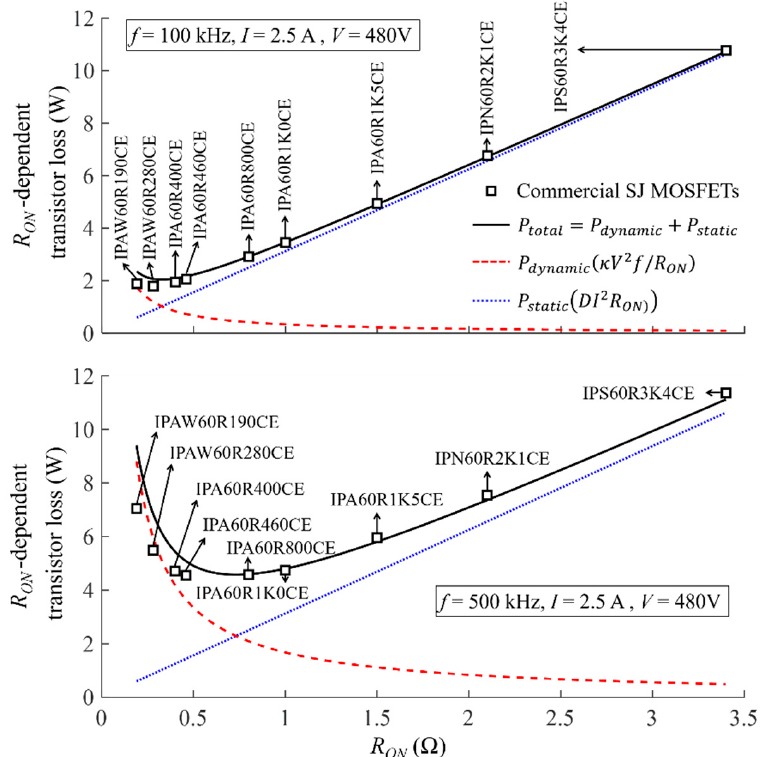
Figure 2. Comparison of the proposed theory at constant output current of 2.5 A with the commer- cially available Infineon CoolMOS CE technology SJ MOSFETs.